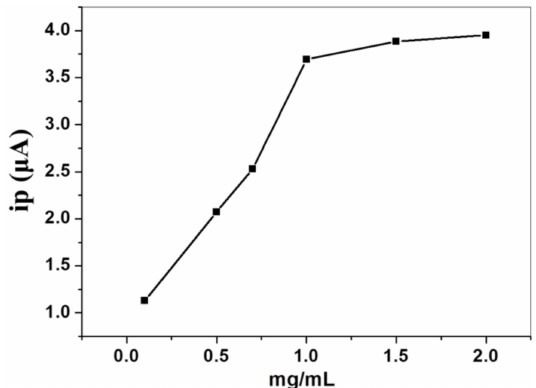
Figure 7. The relationship between the α -NP concentration and the peak current under reaction with 5.0 × 10 2 CFU/mL E. coli